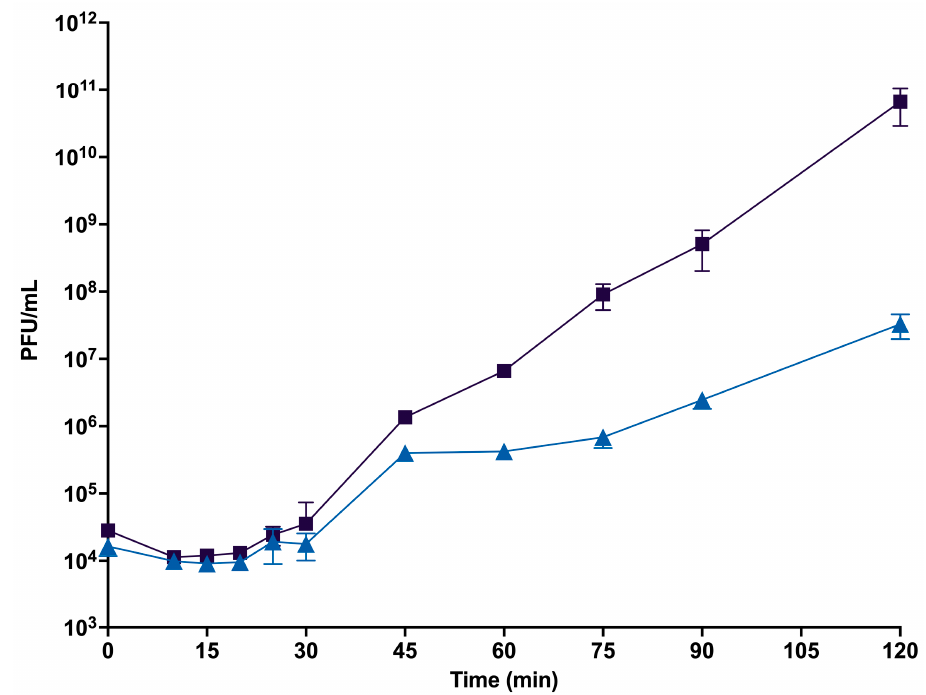
Figure 3. Burst size of phages DLP1 ( ■ ) and DLP2 ( ▲ ) on host strain AB5075 cm . The mean of biological and technical triplicates represented at each time point and error bars represent standard devi- ation.